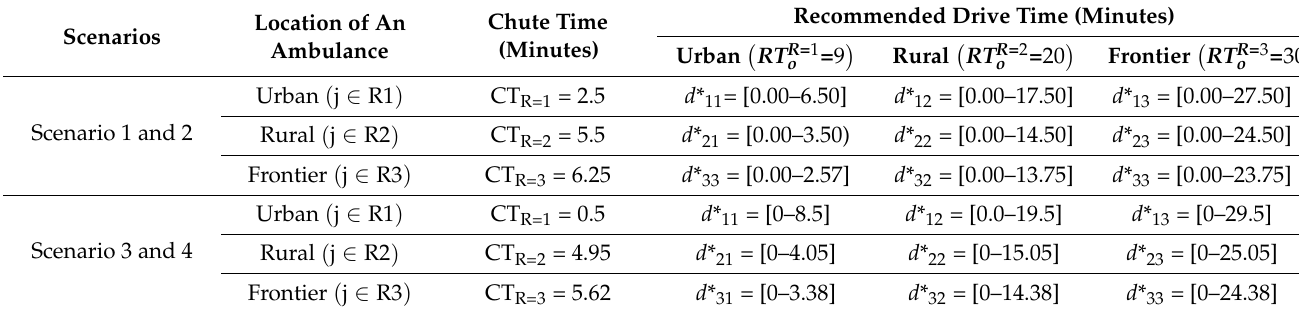
Table 3. Chute time assumption and travel time for each geographical